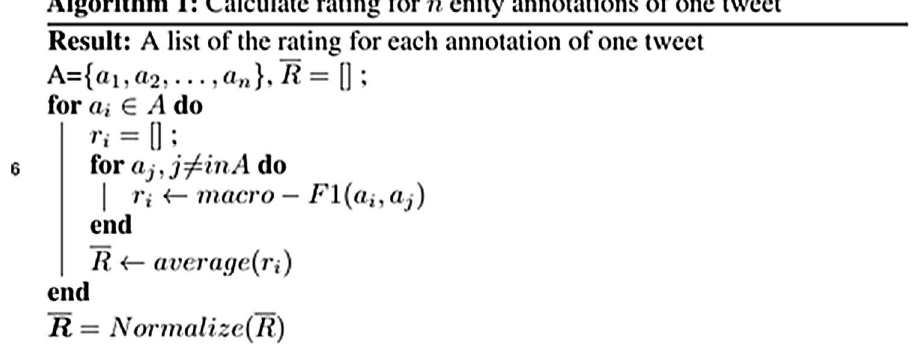
Figure 2. Pseudocode of the inter-worker agreement algorithm.